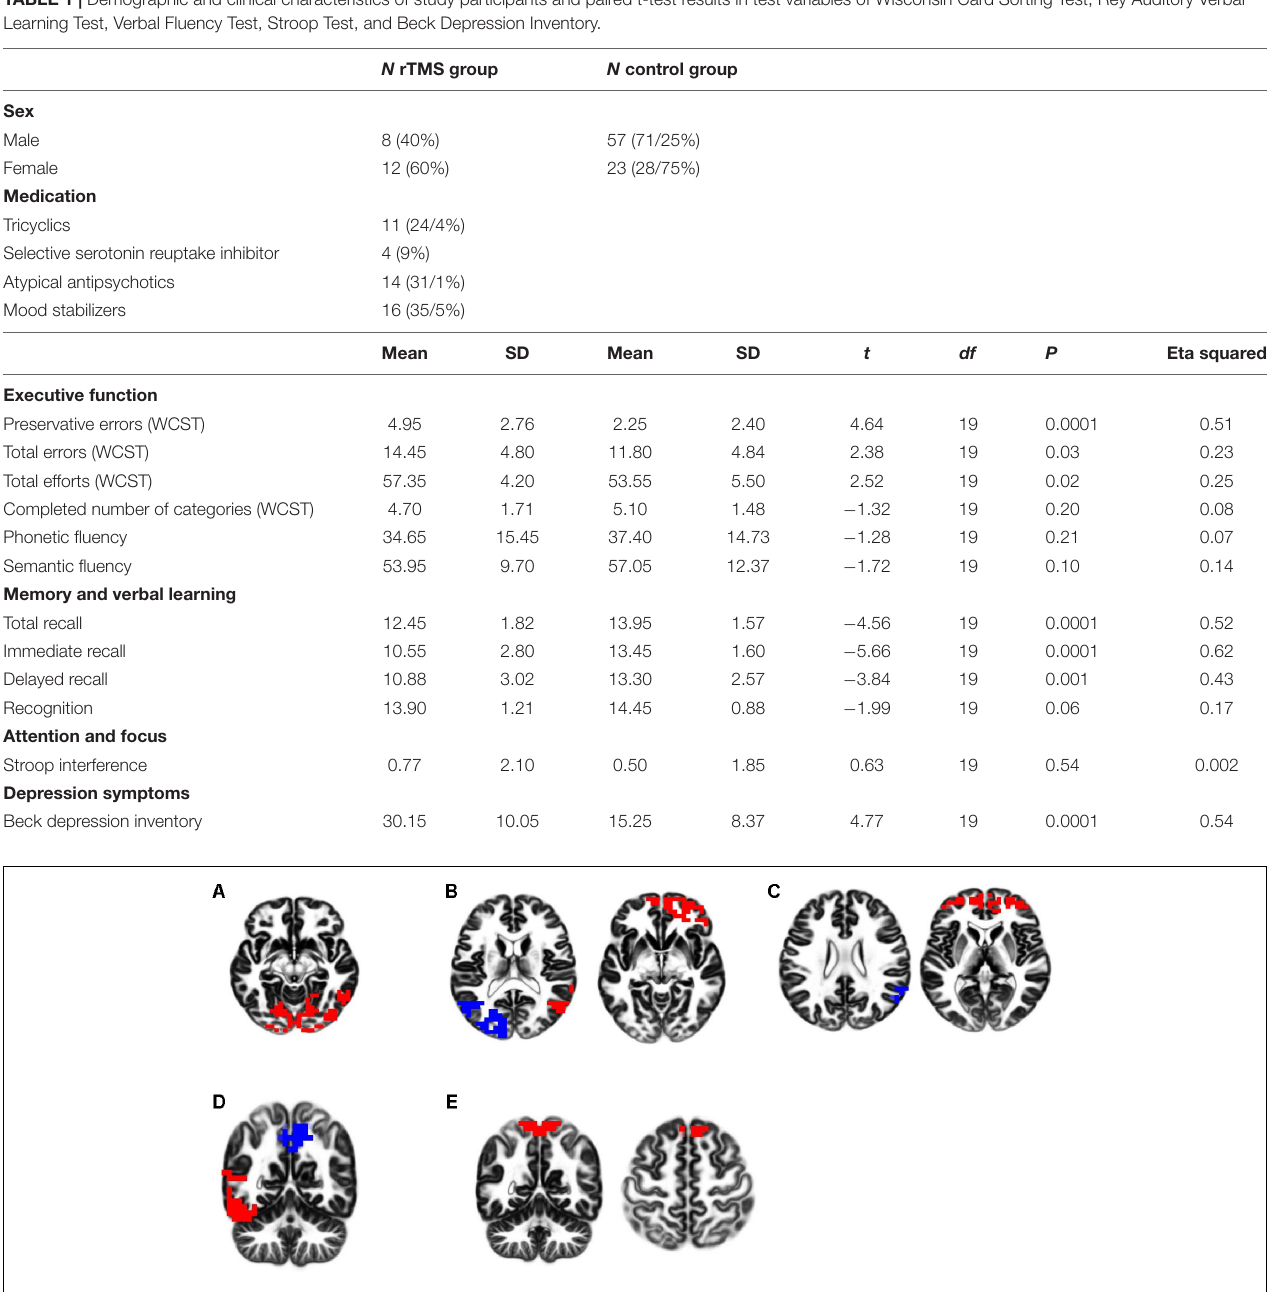
FIGURE 1 | eLORETA-neurophysiological independent components (ICs). Five neurophysiological network activities were identified in the previous study. In respective figures, red and blue voxels indicate increasing and decreasing in power, respectively, with increasing ICs activities. The definitions of these networks are described as follows. (A) IC-4; the visual network in alpha frequency band. (B) IC-5; dual-process of visual perception network, characterized by a negative correlation between the right ventral visual pathway (VVP) in alpha and beta frequency bands and left posterior dorsal visual pathway (DVP) in alpha frequency band. (C) IC-6; self-referential processing network (DMN), characterized by a negative correlation between the medial prefrontal cortex (mPFC) in beta frequency band and right temporoparietal junction (TPJ) in alpha frequency band. (D) IC-9; dual-process of memory perception network, functionally related to a negative correlation between the left VVP and the precuneus in alpha frequency band. (E) IC-10; sensorimotor network (SMN) in beta and gamma frequency bands.